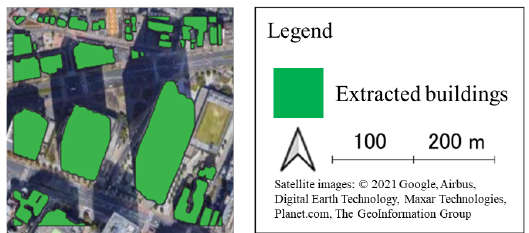
Figure 5. Example of region where the IoU is low